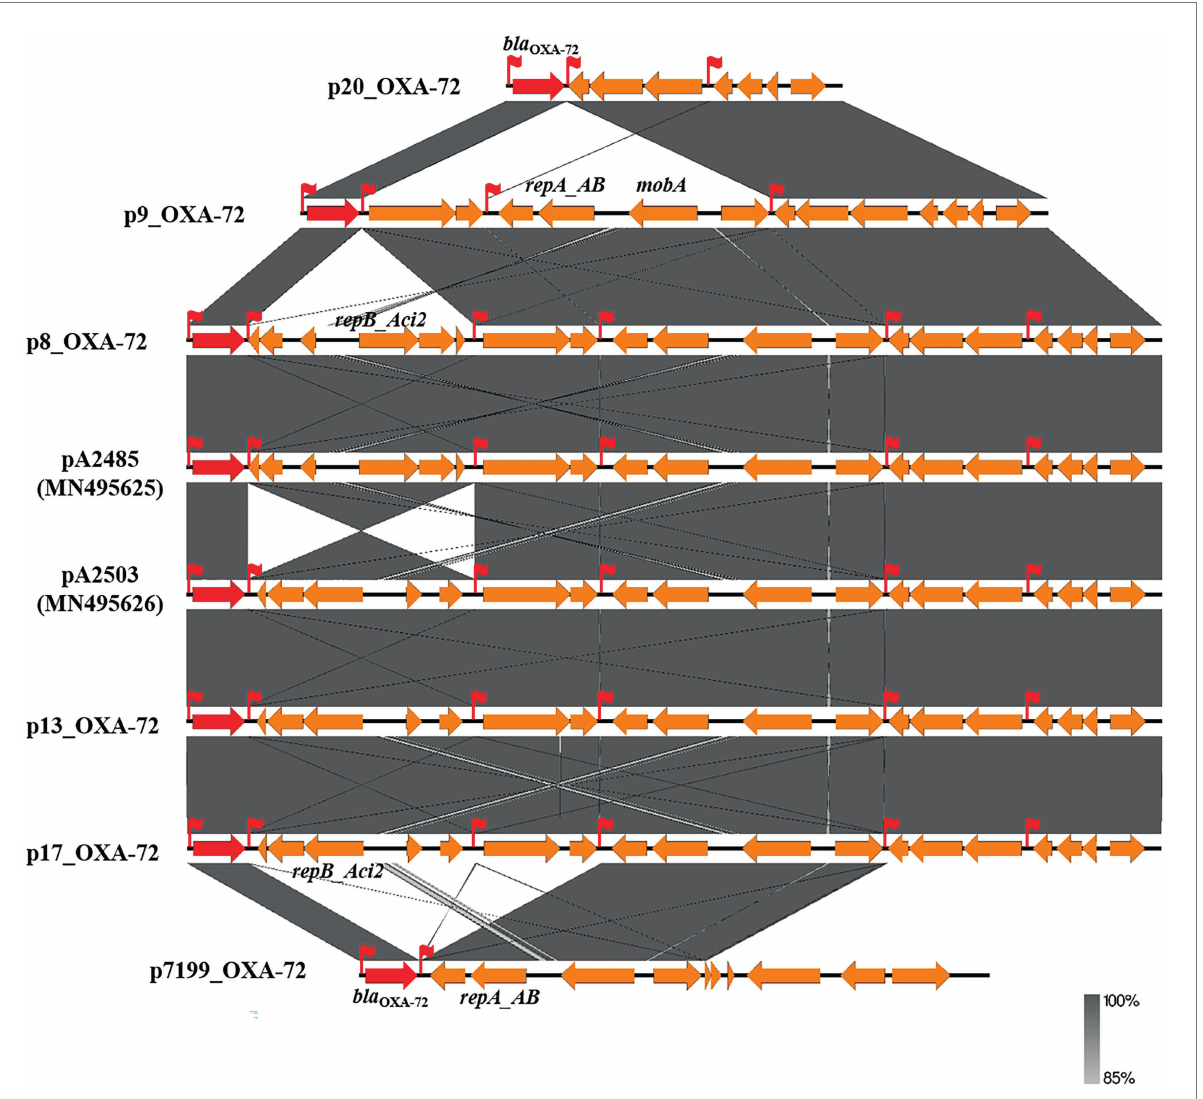
FIGURE 3 Sketch and comparison of the genetic structure of bla OXA-72 -harbouring large contigs. Orange rectangular arrows on the line represent the open reading frames (ORFs) encoded by the contig sequence, and the red arrows represent the bla OXA -gene. The dark grey shadows indicate the 72 identical sequence segment between two contigs. The red flags represent the XerC/XerD-like combination